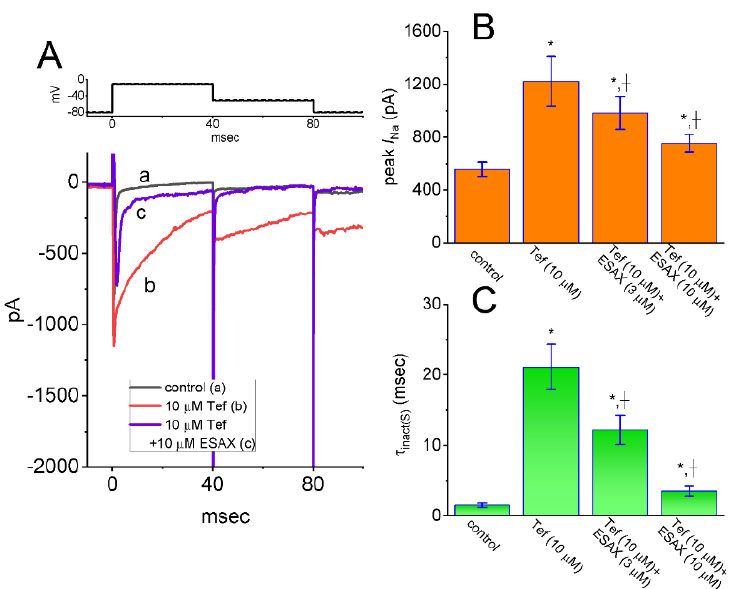
Figure 5. Effect of ESAX on tefluthrin (Tef)-mediated augmentation of I Na recorded from GH 3 cells. ( A ) Representative current traces activated by rapid membrane depolarization (indicated in the upper part). Current trace labeled a is control, that labeled b was taken during exposure to 10 μ M Tef, and that labeled c was obtained in the presence of 10 μ M Tef plus 10 μ M ESAX. The upper part in ( A ) shows the voltage-clamp protocol applied. Summary bar graphs shown in ( B , C ) respectively demonstrate effects of Tef or Tef plus ESAX on peak I Na and the time constant ( τ inact(S) ) in the slow component of I Na inactivation (mean ± SEM; n = 7 for each bar). * Significantly different from controls ( p < 0.05), and + significantly different from Tef (10 μ M) alone group ( p < 0.05).